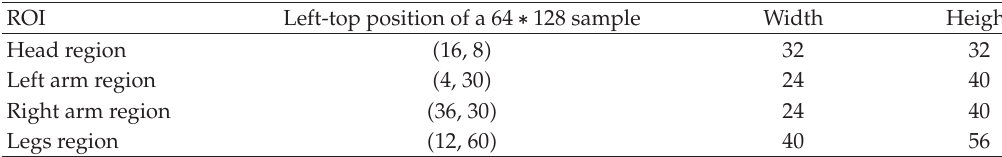
Table 1: Location of ROI in the